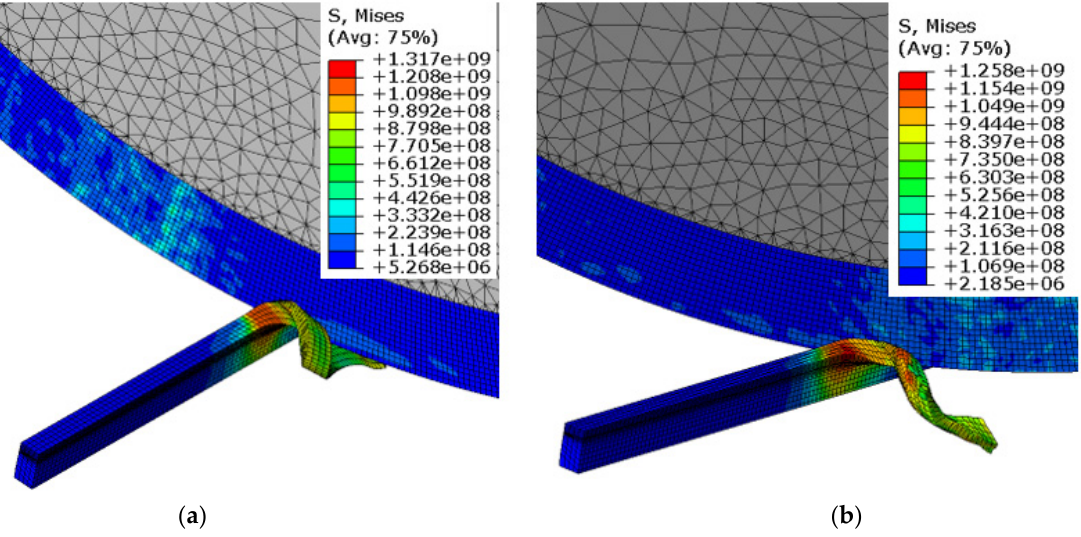
Figure 5. Chip formation and von-Mises-stress contours for SPRT and workpiece at different inclina- tion angles: ( a ) i = 9 ◦ , ( b ) i = 25 ◦ (V = 100 m/min, f = 0.1 mm/rev, d = 0.3